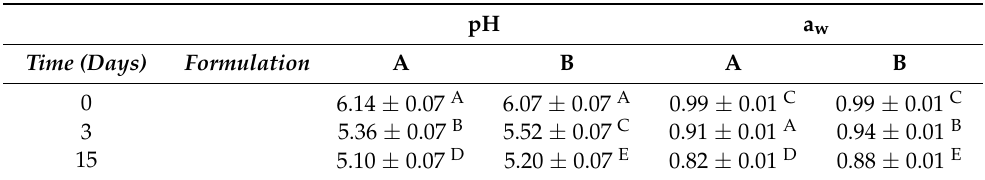
Table 1. Evolution of pH and a w in spontaneously fermented sausages containing goat